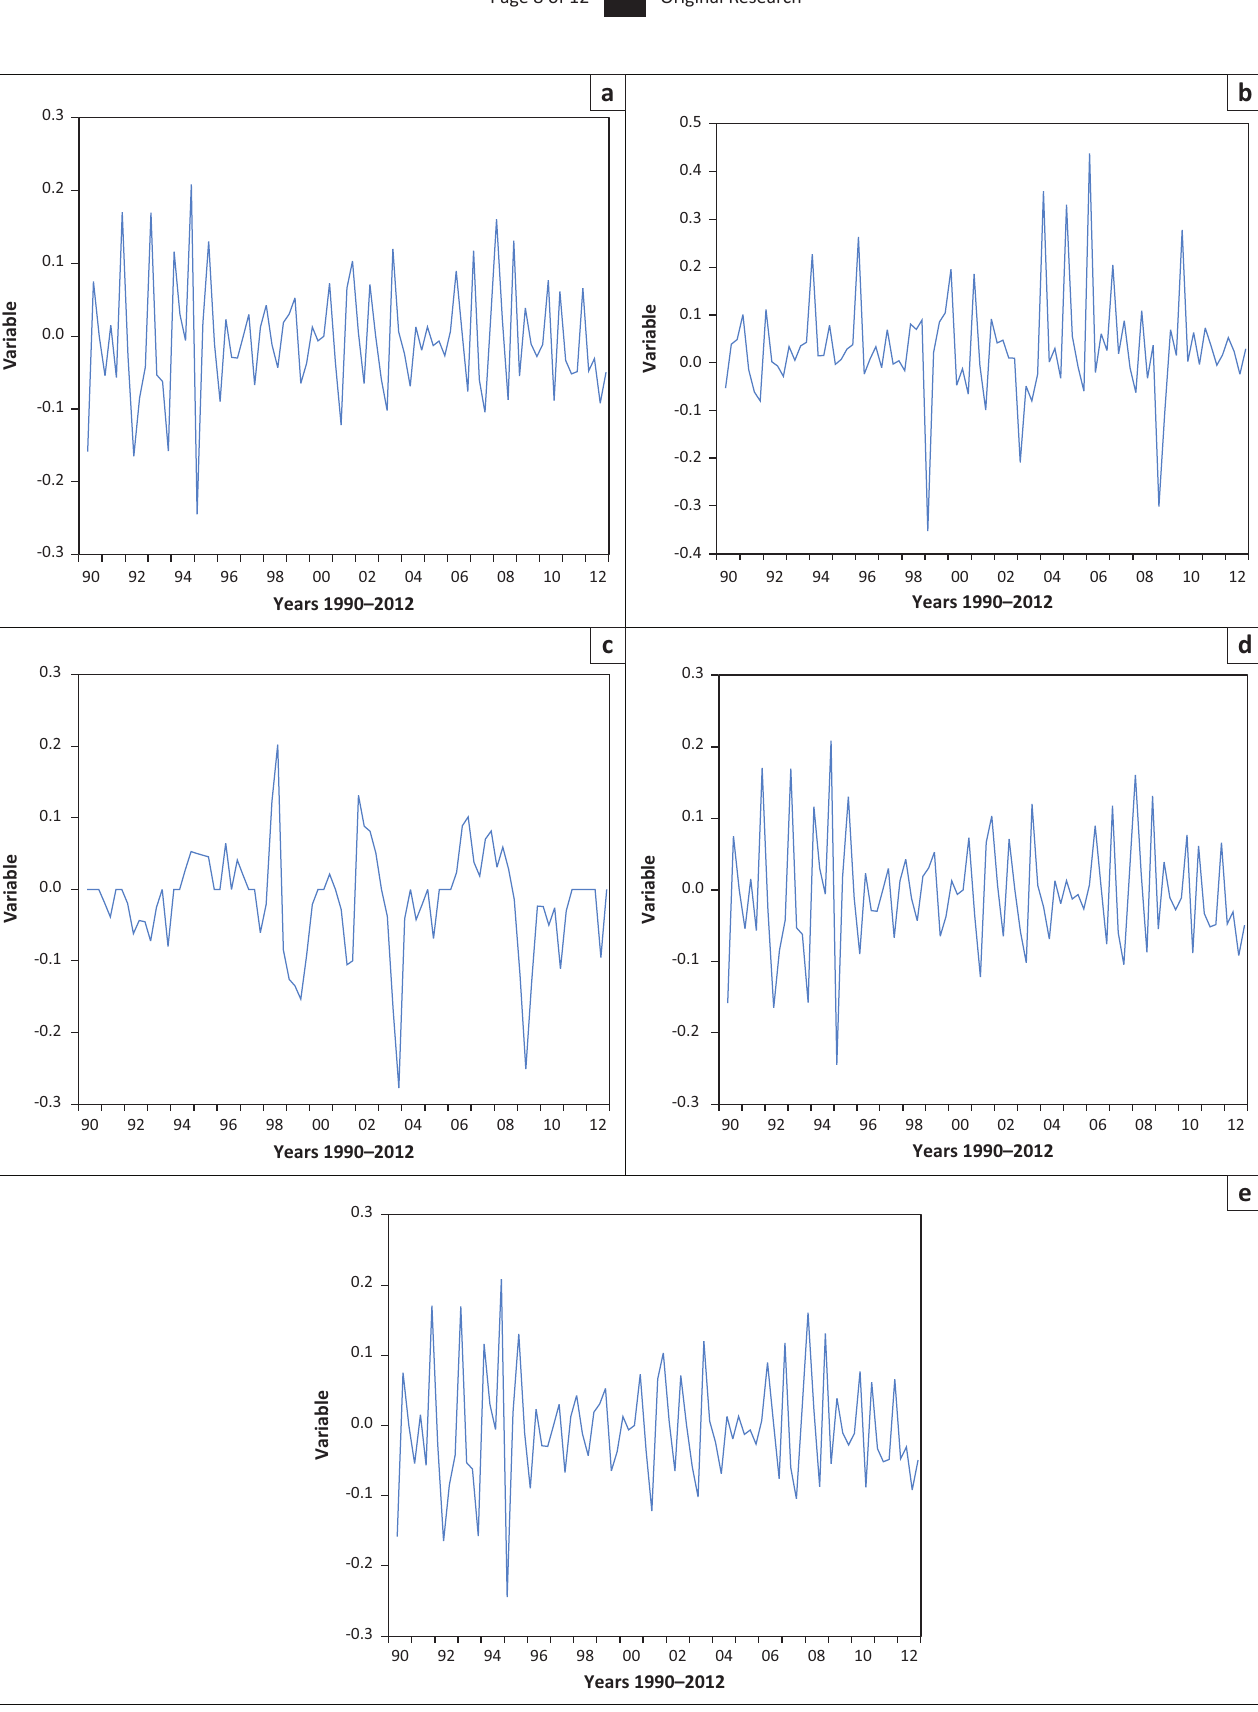
FIGURE 2: Differential series. (a) Economic development, (b), road transport investment (c) government expenditure on road transport, (d) exchange rate and (e)